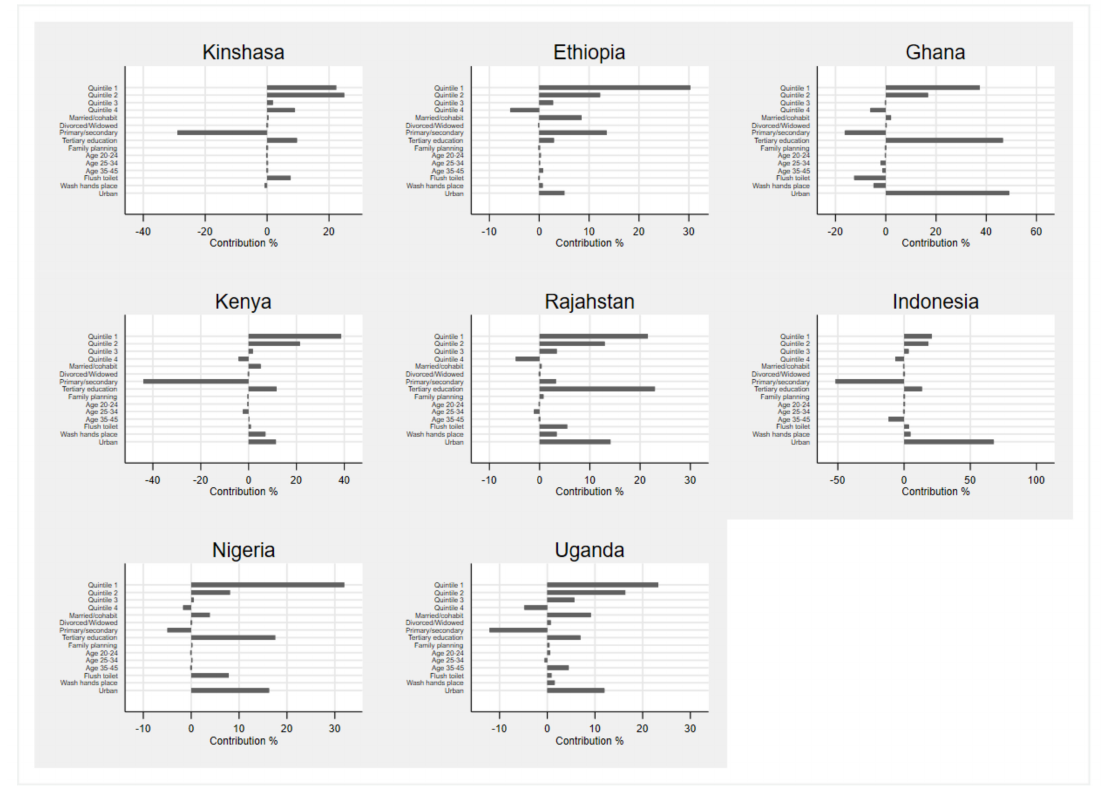
Figure 1. Contribution % of various factors to the CCIs of sanitary pad